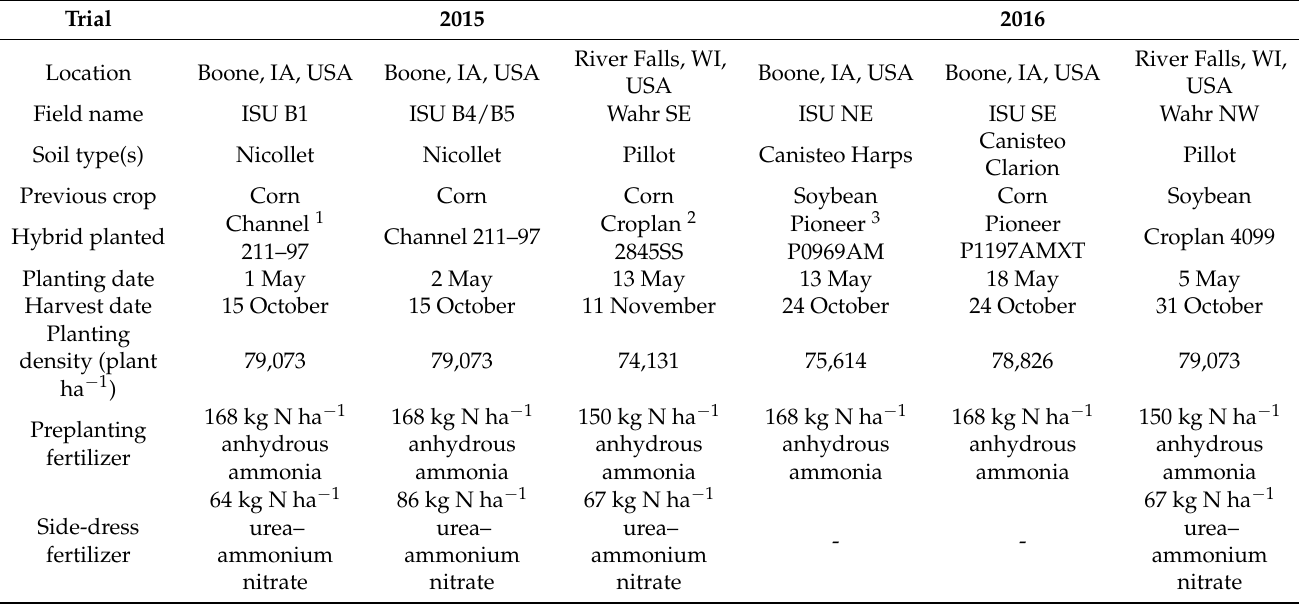
Table 1. Agronomic management practices of six uniformity trials conducted to investigate the effect of plot shape and size on the variance of maize